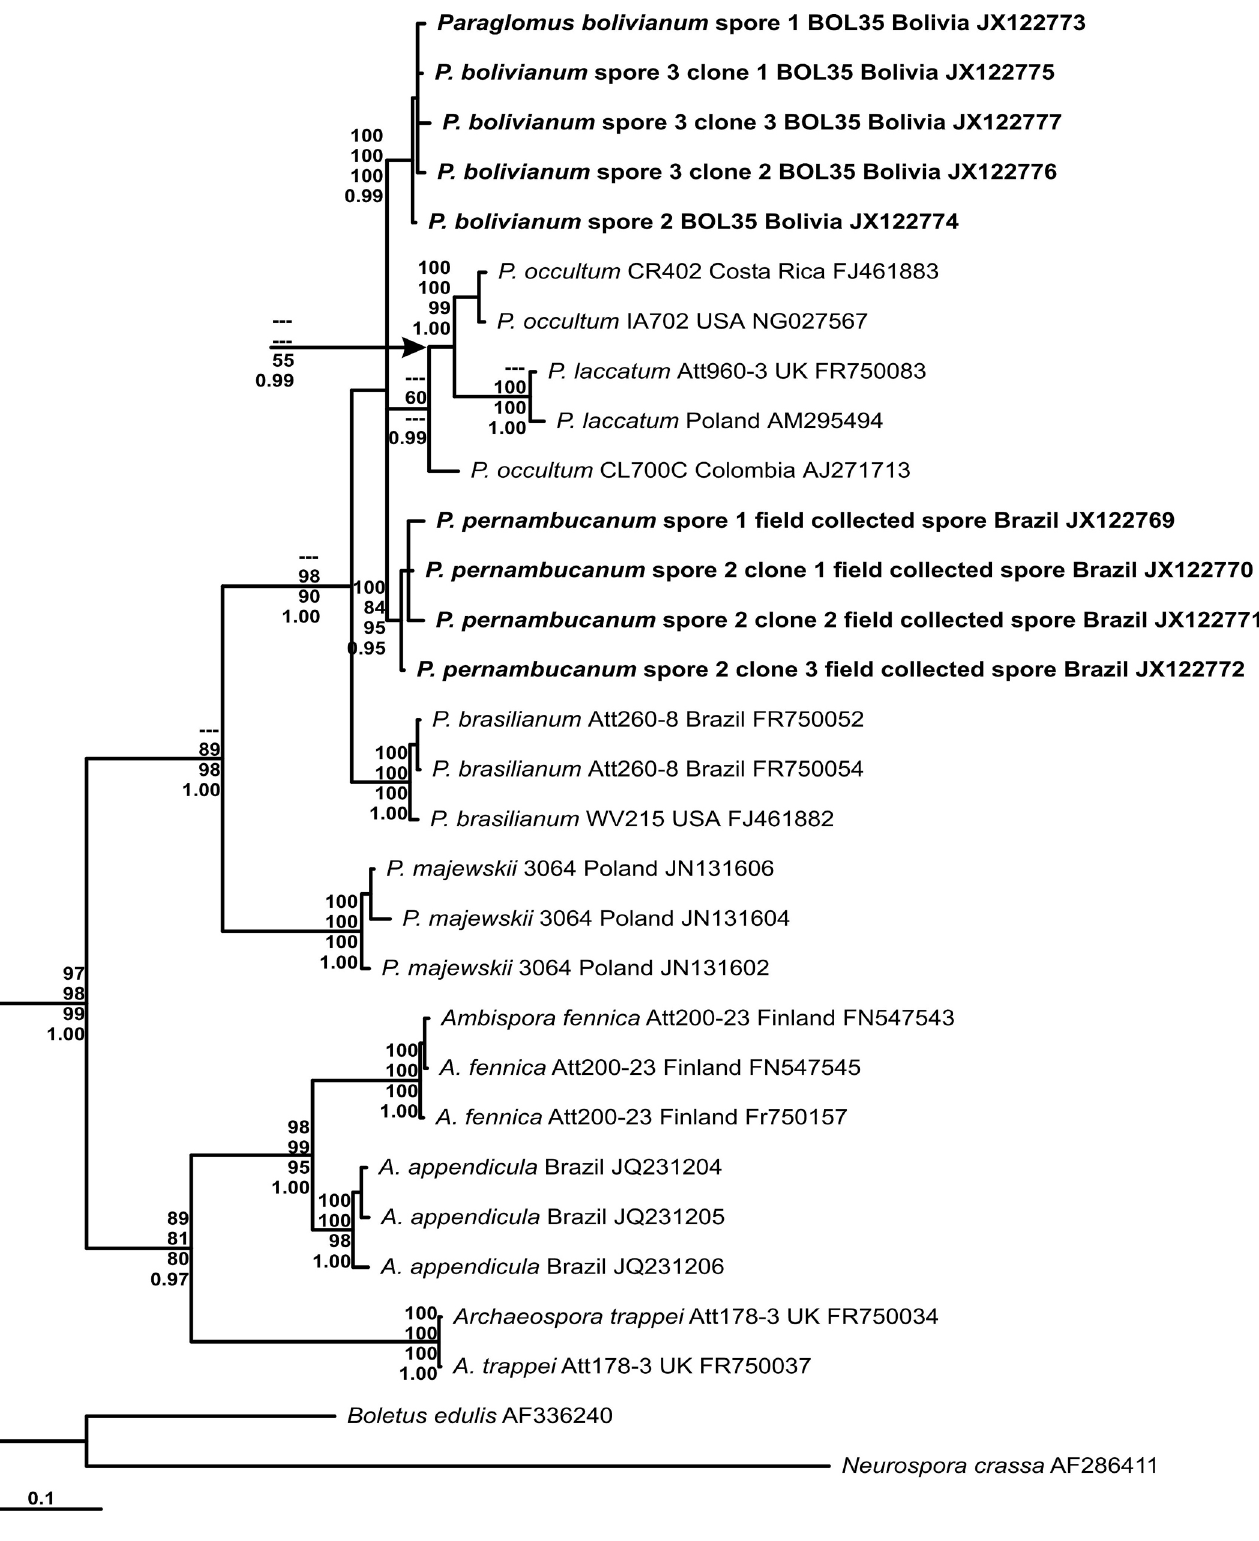
Fig. 1: Phylogenetic tree of the Paraglomeromycetes and Archaeosporomycetes based on analysis from partial sequences of the LSU rRNA gene. Boletus edulis and Neurospora crassa were used as outgroup. Sequences are labeled with database accession numbers. Support values (from top) are from neighbor-joining (NJ), maximum parsimony (MP), maximum likelihood (ML) and Bayesian analyses, respectively. Sequences obtained in this study are in bold. (Consistency Index = 0.70; Retention Index =